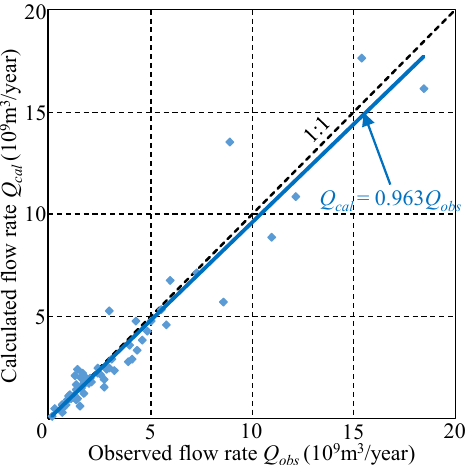
Figure 6. Correlation between annually observed discharge, Q obs , and calculated river discharge, Q cal , at the mouths of 109 class-A river systems. The dashed line represents a 1:1 correspondence.